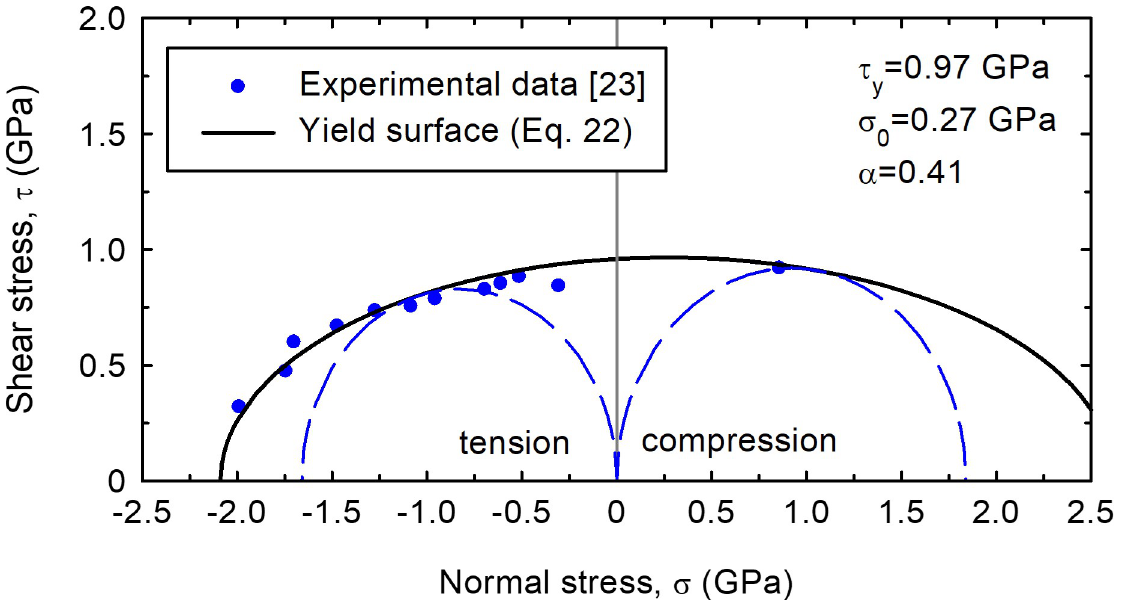
Fig 6. Fitted yield surface of a metallic glass tested by Qu et al. [23].